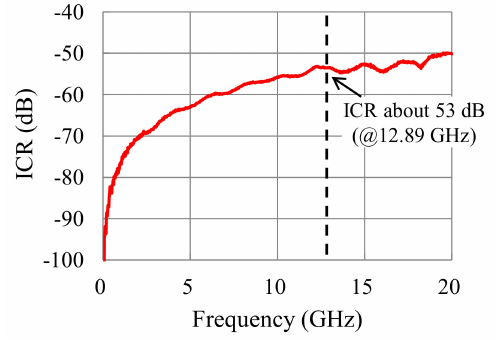
Figure 9. Measured insertion-loss-to-crosstalk ratio (ICR) characteristic.